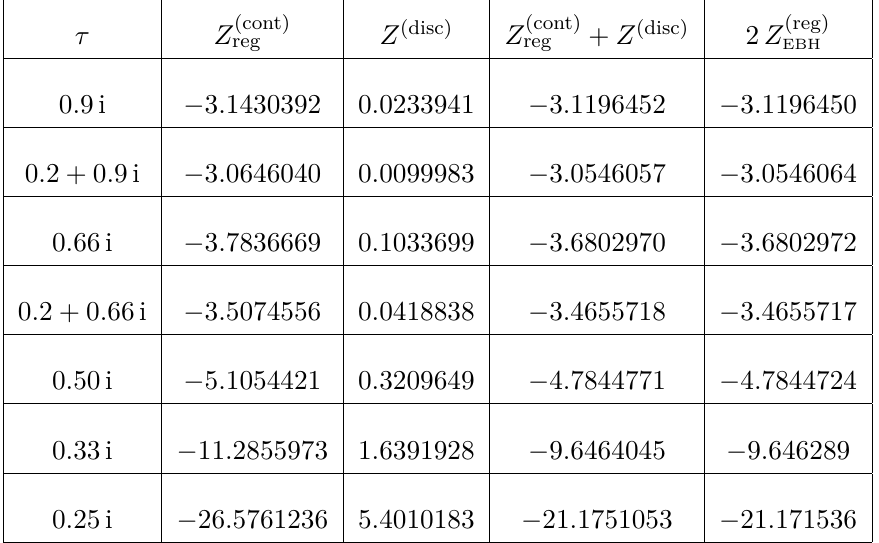
Table 2 . The last column contains numerical data for 2 Z (reg) be k = − 0 . 1 and n = 3 . This is compared to Z (cont) reg + Z (disc) , where Z (disc) was computed using eqs. (7.17), (7.18) and Z (cont) reg via